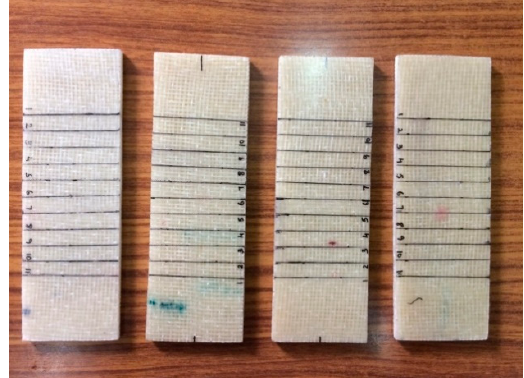
Figure 3. Samples used for the impulsive excitation of vibration.